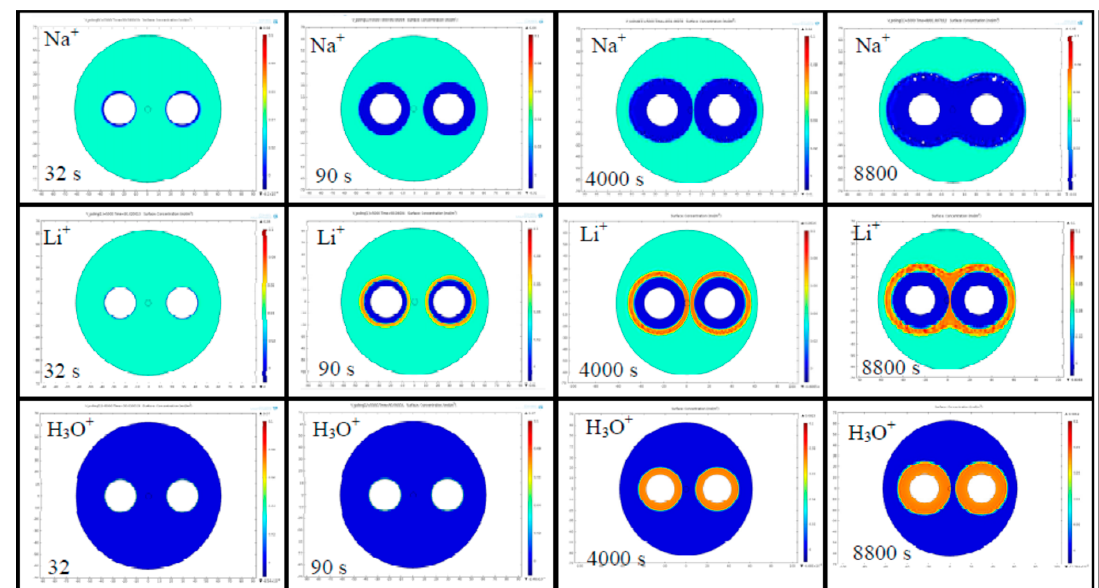
Figure 2 : Temporal evolution of the mobile cations for a Germania doped twin-hole fused silica fiber poled in a cathode-less configuration (the two electrodes inserted in the two cladding channels are connected to the same potential of 5 kV). The injection of the H 3 O + ions is considered inexhaustible and capable to neutralize the non-bridging oxygen (NBO − ) centres depleted of the impurity positive ions moved because of the application of the external electric field [39].